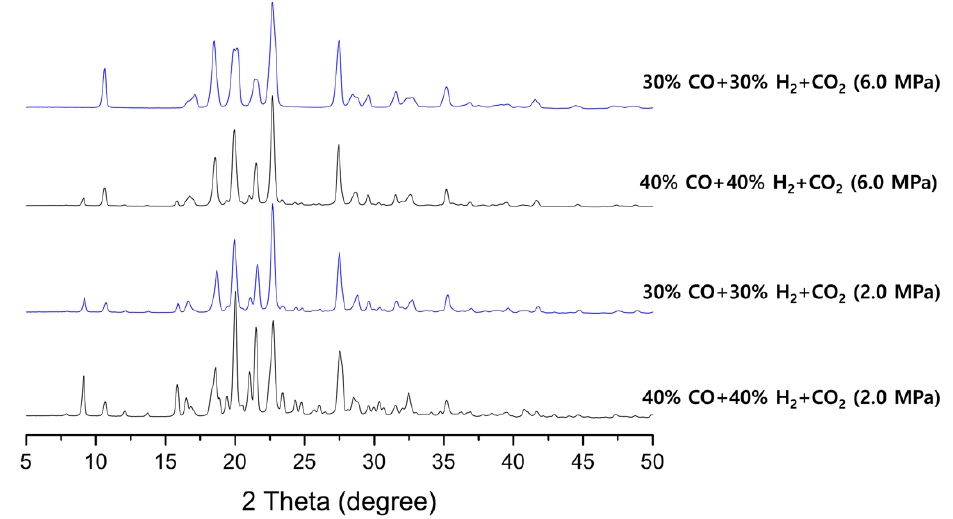
Figure 4. X-ray di ff raction (XRD) patterns for hydroquinone (HQ) samples after reaction with ternary (CO 2 + CO + H 2 ) gas mixtures at 2.0 and 6.0 MPa. Blue plots represent HQ samples after reaction with the ternary (30% CO + 30% H 2 + 40% CO 2 ) gas, while black ones represent HQ samples after reaction with the ternary (40% CO + 40% H 2 + 20% CO 2 ) gas.